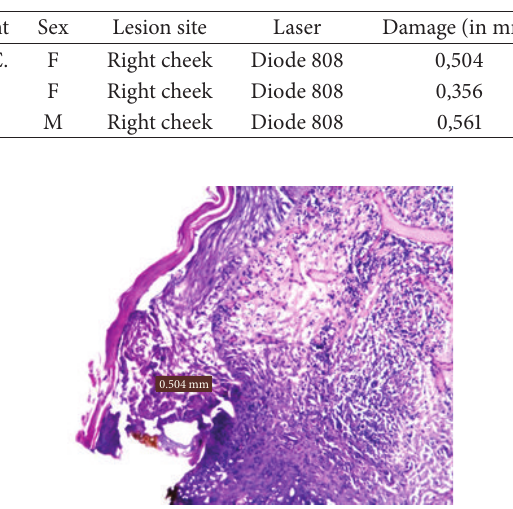
Table 3: Hyperkeratotic lesion biopsies.